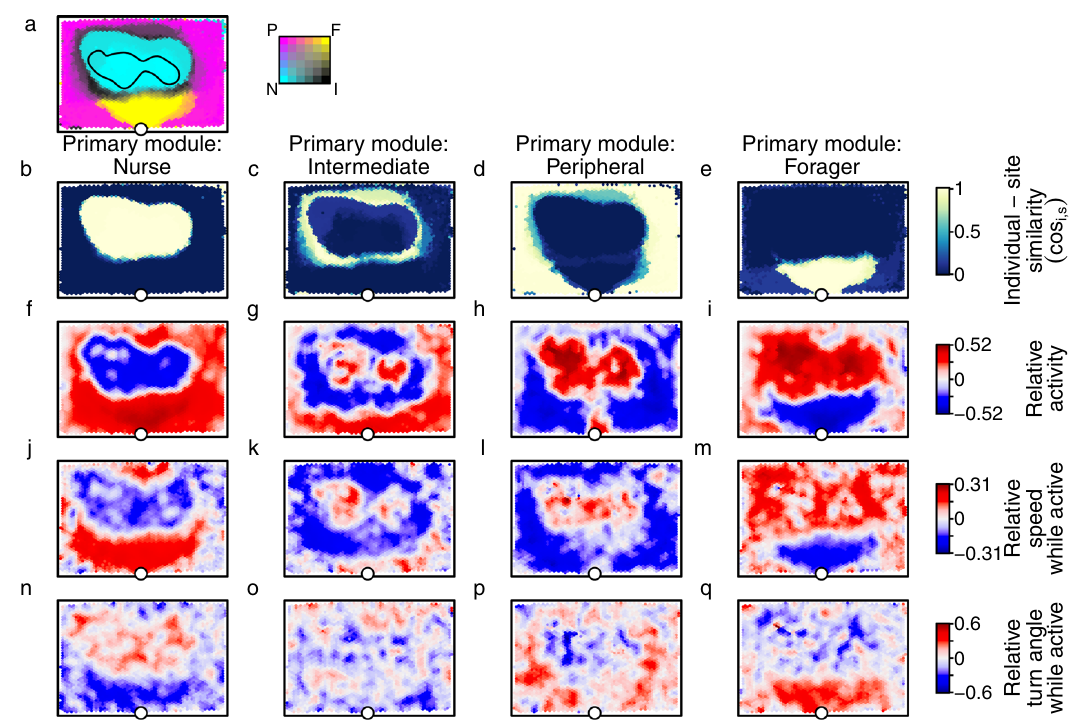
Fig. 7 | Visualising location-dependent locomotion adjustment . All panels show dataforarepresentative L.acervorum colony. a Mapshowingthepartitioningofthe nest into four spatial modules. b – e Maps depicting the individual-site similarity betweenthe observedmodulescores of allsites and those ofavisiting worker that scored 1 for the indicated module. f – q Maps depicting spatial variation in move- ment parameters according to primary module. Site colours show movement metrics for individuals with the indicated primary module. To facilitate compar- isons between modules, all three movement metrics are expressed as relative measures,i.e.,signeddifferencesbetweenthemeanactivityprobability( f – i ),mean speed( j – m ),ormeanturnangle( n – q )calculatedacrossallvisitsbyindividualswith